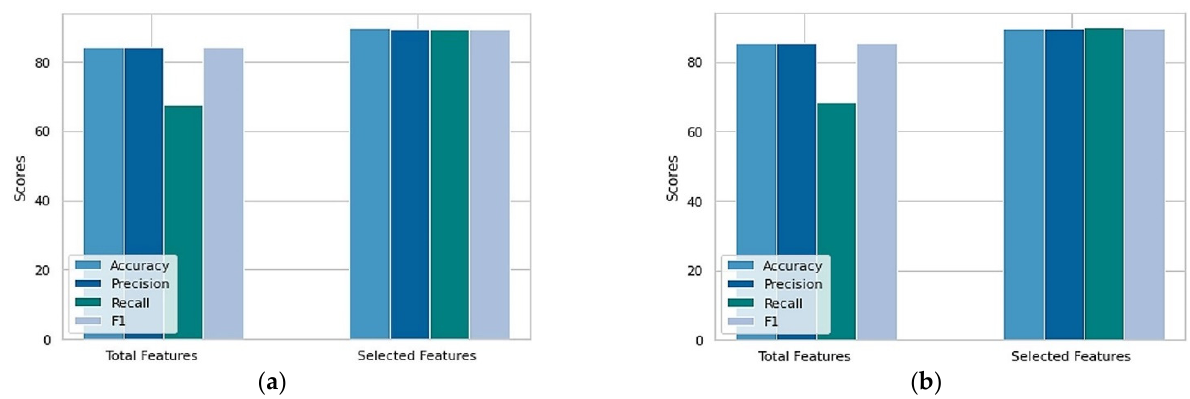
Figure 7. Performance of proposed algorithm. ( a ) Cleveland dataset; ( b ) Statlog dataset.